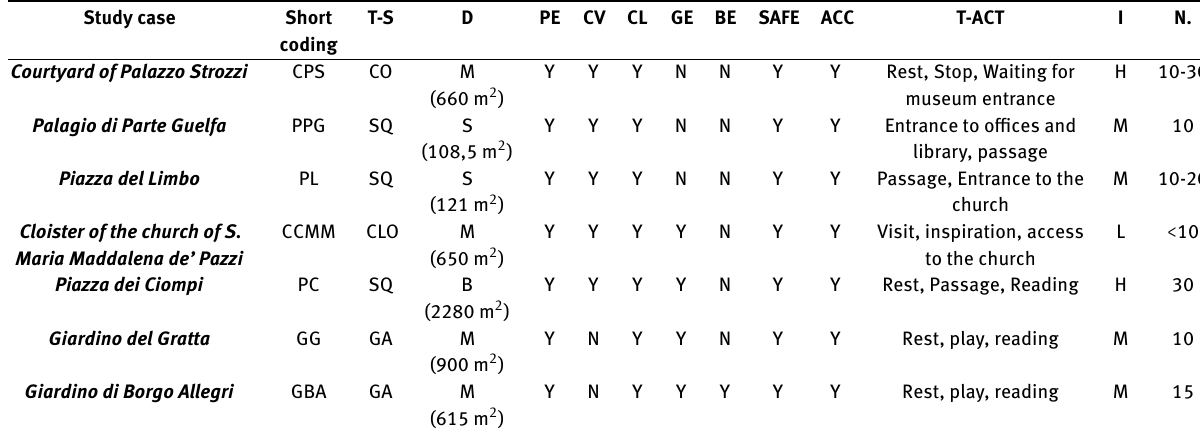
Table 1: Expert’s analysis datasheet Study